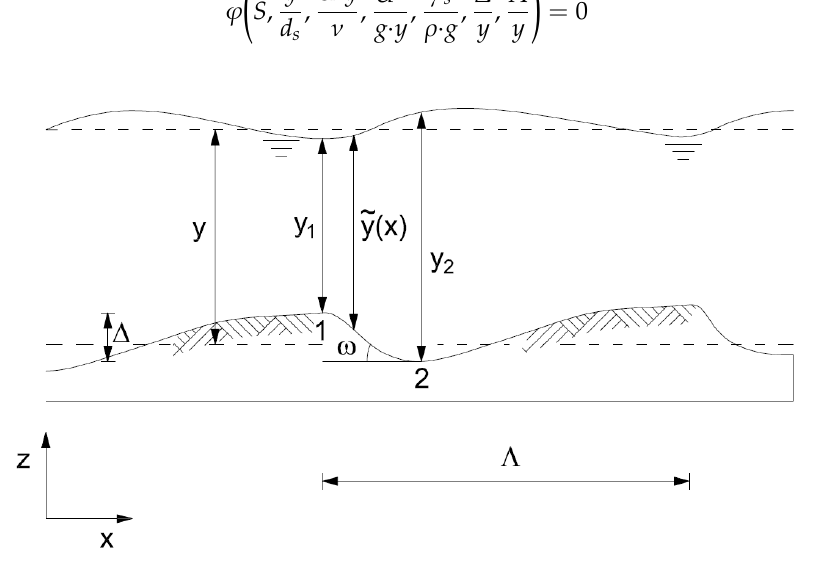
Figure 1. Schematic representation of 2-D flow in presence of dune.